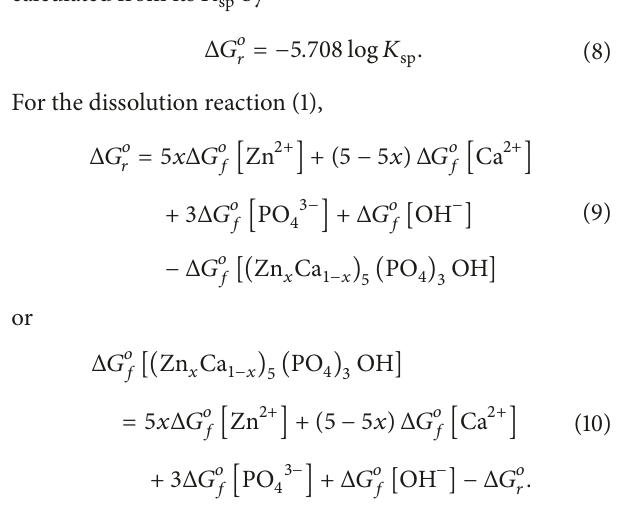
Figure 7: Change of the solubility product and the free energy of formation with the increasing 𝑋 Zn for the Zn-substituted hydroxy- lapatites [(Zn Ca 1− ) 5 (PO 4 ) 3 OH] at 25 ∘ C. x x